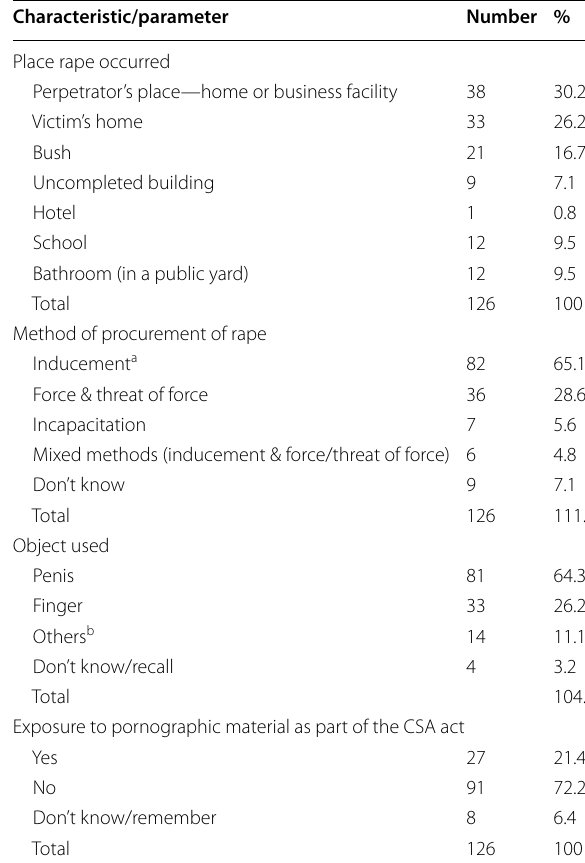
Table 4 Characteristics of the index rape